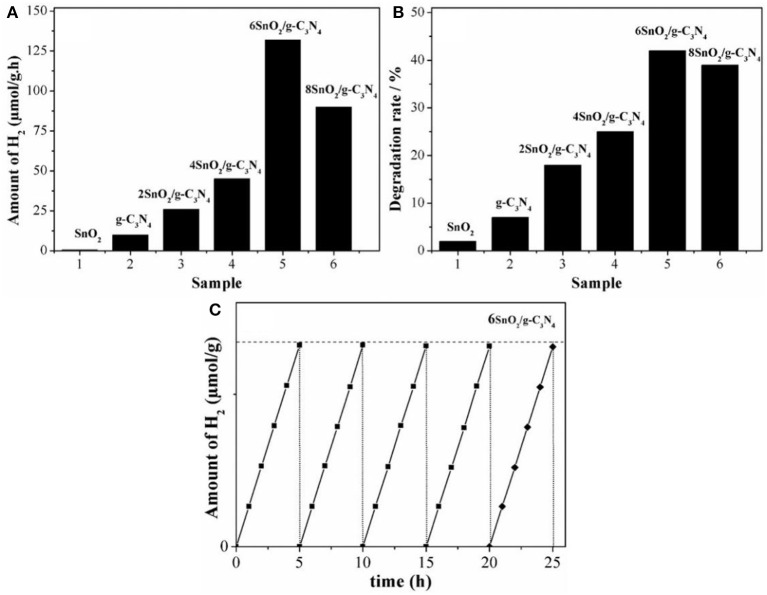
Photoactivities for H2 evolution (A), 2-CP degradation (B) of pure g-C3N4, and XSnO2/g-C3N4 and stability test of 6SnO2/g-C3N4
(C).